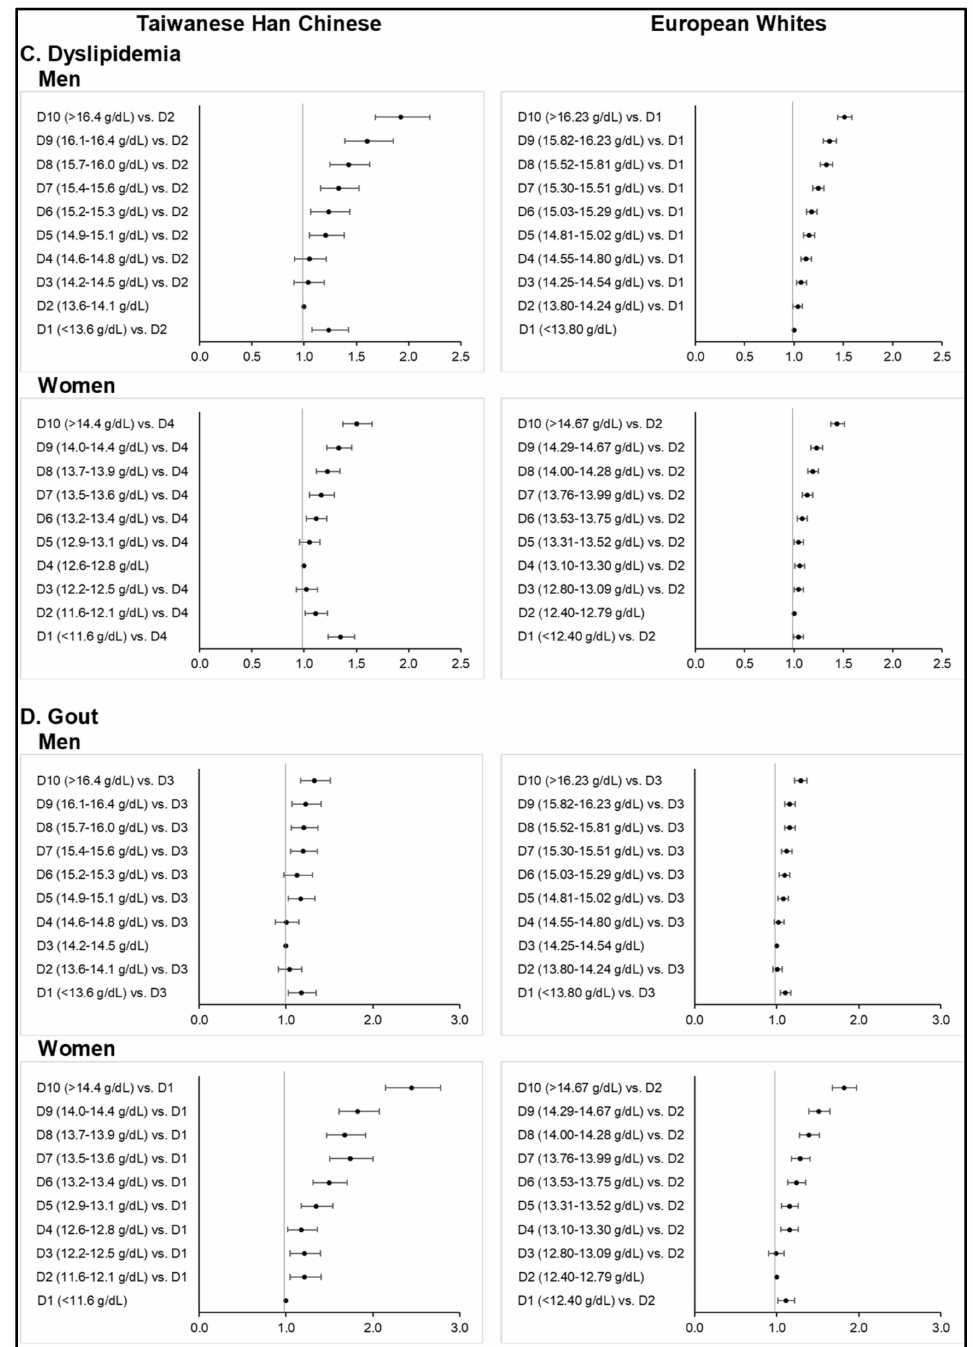
Figure 2. Odds ratios of central obesity, hypertension, dyslipidemia, and gout across increasing deciles of hemoglobin concentration among Taiwanese Han Chinese and European Whites (top: men, bottom: women). Final models adjusted for age, age-squared, smoking status, alcohol consumption, physical activity level, highest educational attainment, and comorbidities, as well as menopausal status in